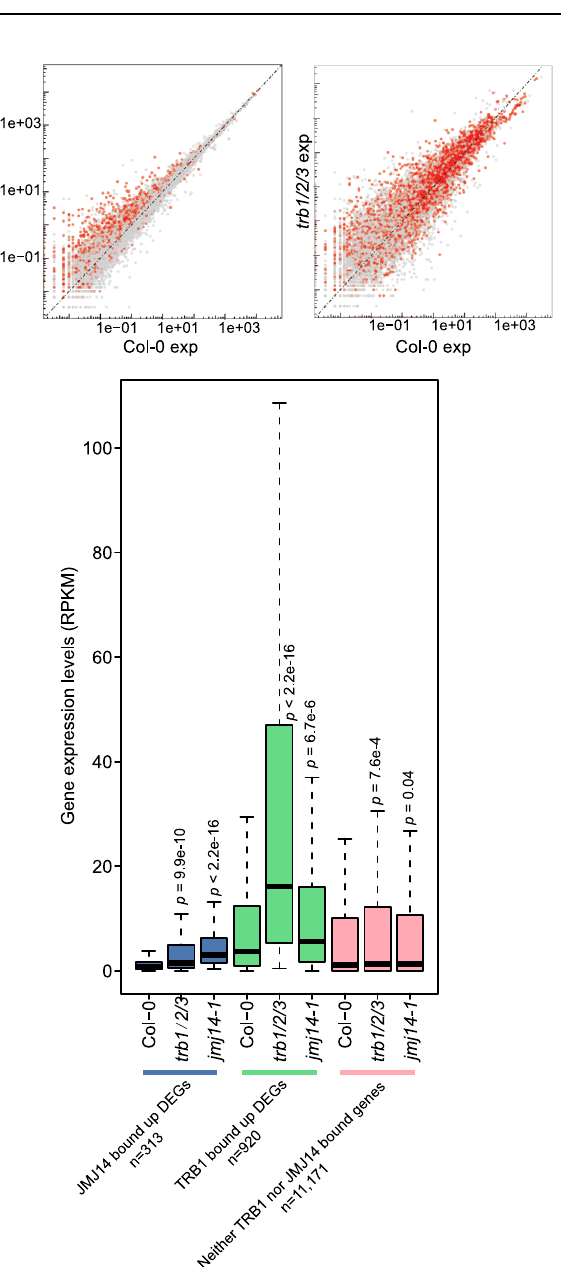
Fig. 4 | Up-regulated DEGs in jmj14-1 and trb1/2/3 mutants are partially over- lapping. a Scatterplot showing the gene expression level in jmj14-1 vs Col-0 (left panel) and trb1/2/3 vs Col-0 (right panel). The red dots highlight genes bound by JMJ14(leftpanel)orTRB1(rightpanel). b Boxplotsdepictingtheexpressionlevelof FLAG-JMJ14 bound and up-regulated DEGs, FLAG-TRB1 bound and up-regulated DEGs, and neither TRB1 nor JMJ14 bound genes, in Col-0, trb1/2/3 , and jmj14-1 mutants, respectively ( n =3 biologically independent samples). The top, mid-line, and bottom of the boxplots represent the upper quartile, median, and lower